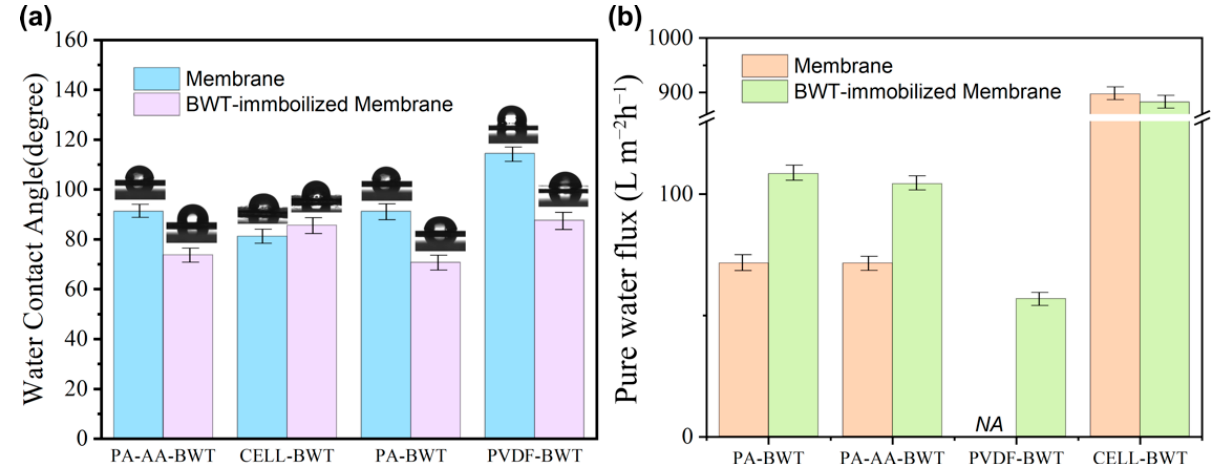
Figure 4. ( a )Water contact angle of membrane and BWT-immobilized membrane and ( b ) pure water flux of membrane and BWT-immobilized